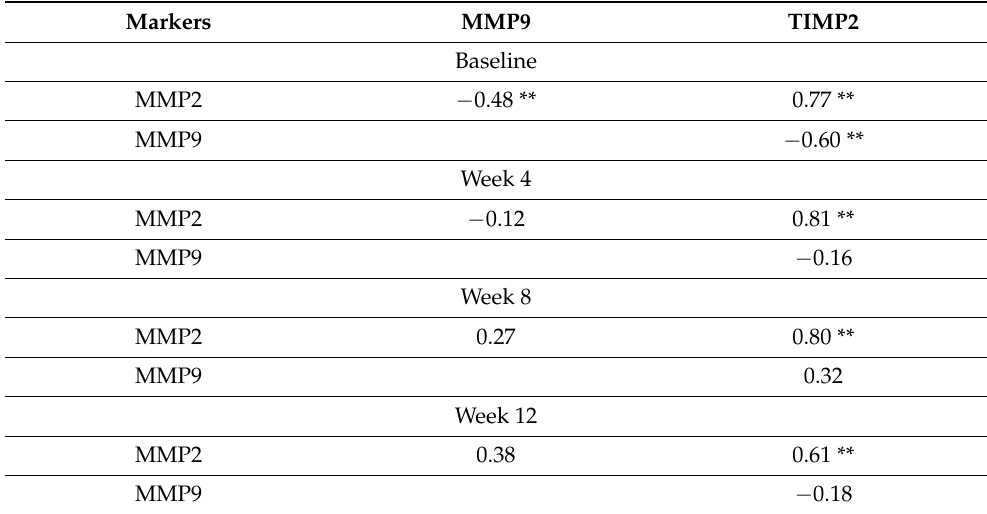
Table 3. Spearman correlation coefficients between different